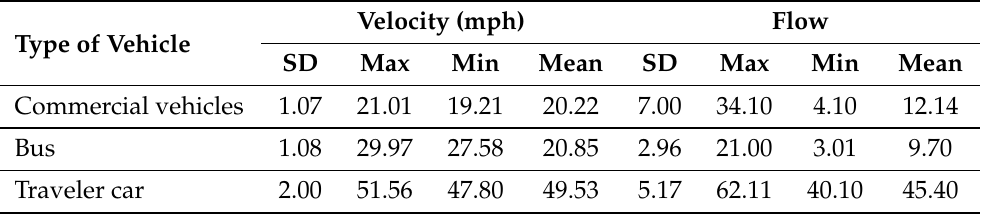
Table 5. Velocity and traffic Flow measurement for 5 min